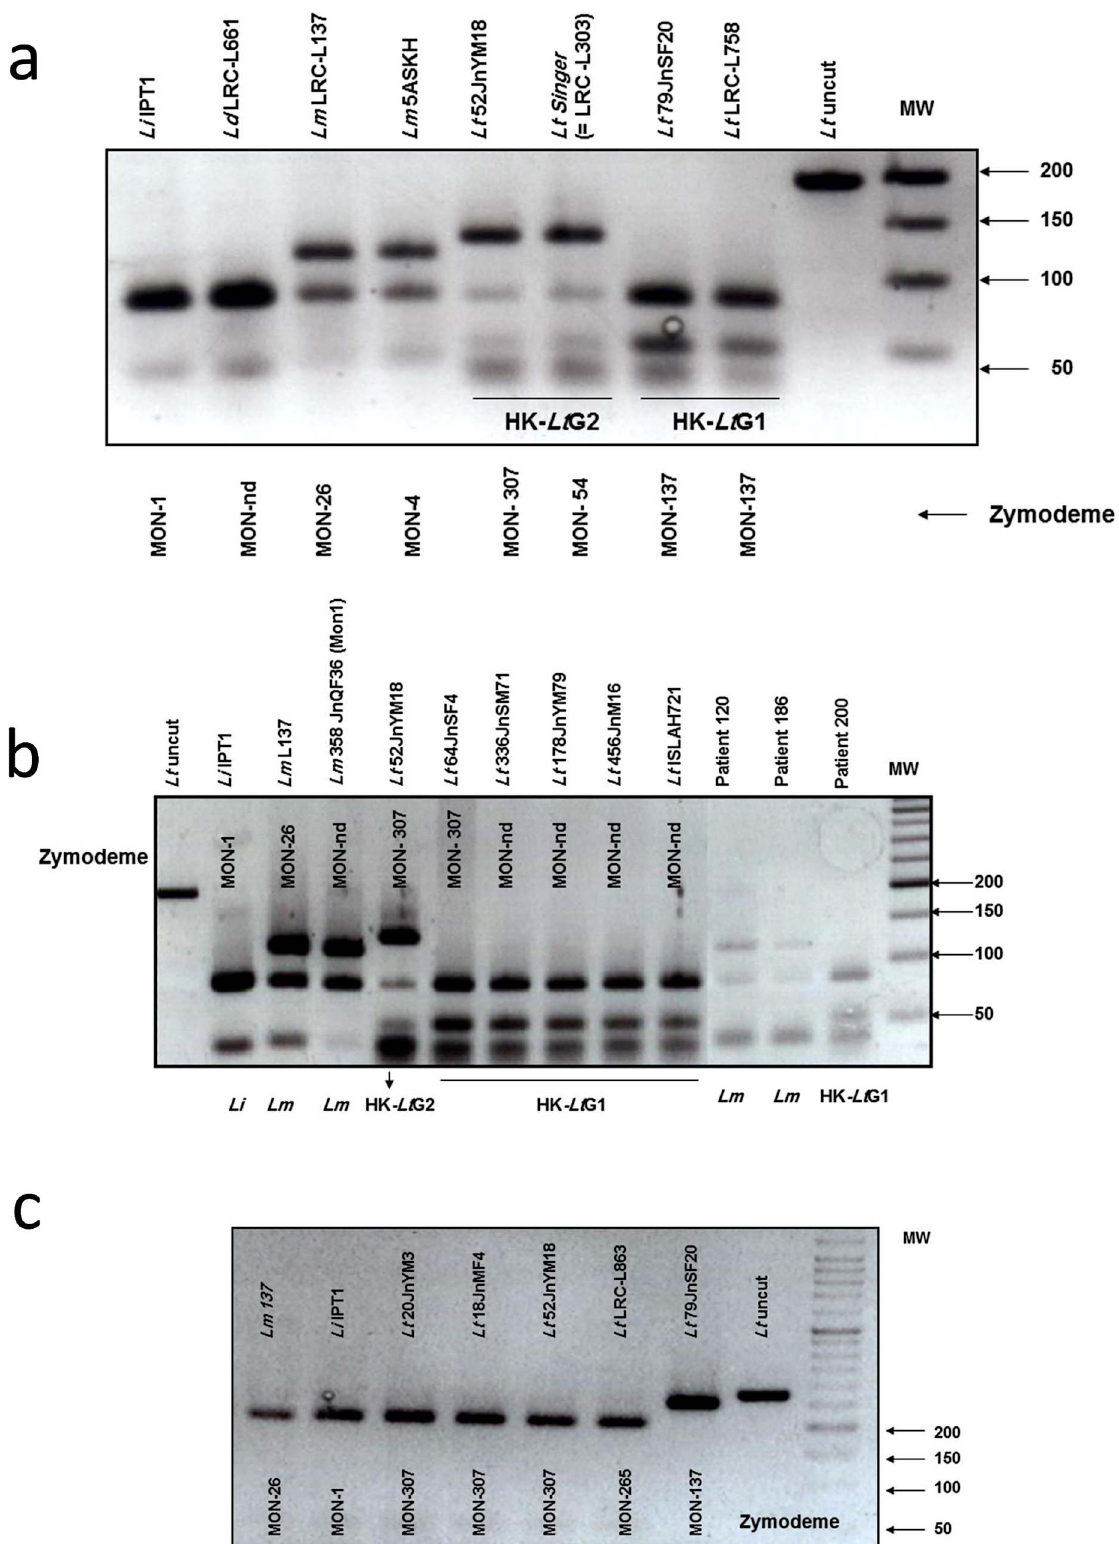
Figure 2. Agarose gel electrophoresis of : a) the PCR products from the Hexokinase (HK) genes of leishmanial reference strains after their double digestion with the endonucleases MboI and HaeIII , nd=not done; b) of PCR products from the HK genes of the leishmanial references and local Israeli and Palestinian strains, and Palestinian clinical samples after their double digestion with the endonucleases MboI and HaeIII . Uncut PCR product from L. tropica MHOM/PS/18JnMF4 (=LRC-L891) was used as a control and molecular